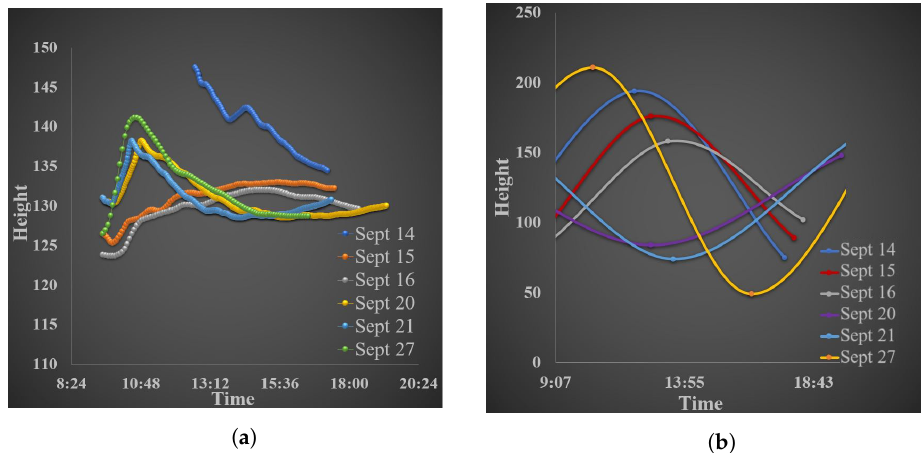
Figure 15. Sea level height data measured by the proposed system and published by government.